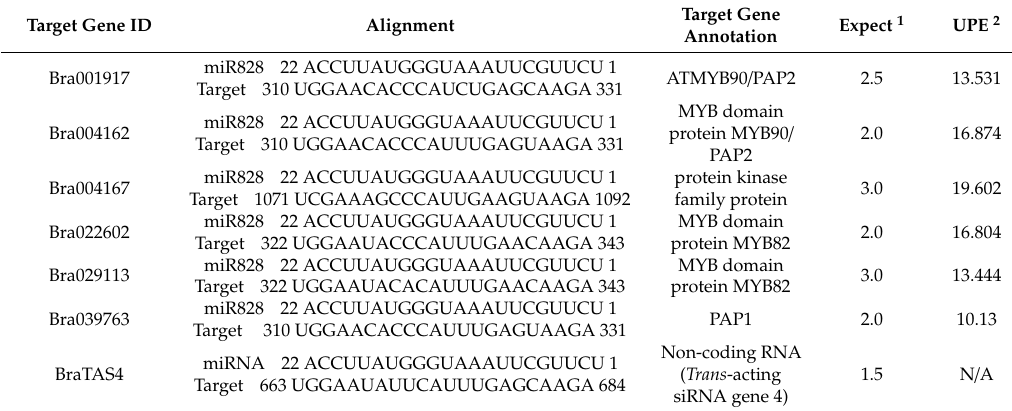
Figure 3. Three candidate primary miR828 transcripts were identified by qRT-PCR and sequences alignment showed they are respectively located in B. rapa chromosome A03, A08, and A01. ( A ) Electrophoresis of PCR product on agarose gel. ( B ) The sequences of these primary miR828 transcripts are highly similar except that primiR828-A01 has a 14 bp sequence deletion. The sequences in blue box and purple box respectively represent the region of miR828a and miR828b. Table 1. The predict targets of miR828 and annotation by psRNATarget using Brassica rapa cds library (version 1.1, released on 30 August 2011).